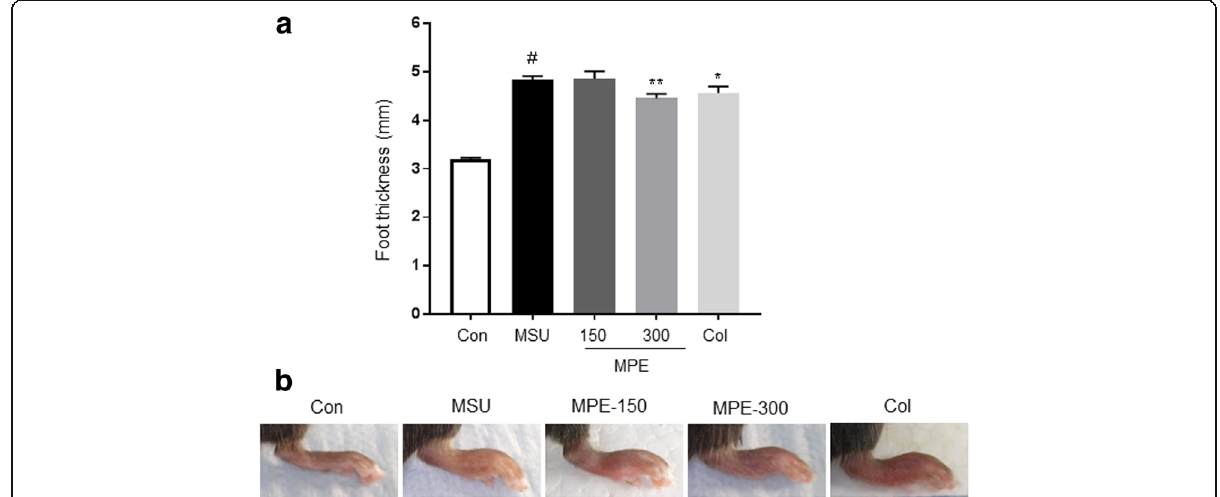
Fig. 1 Effect of MPE on paw edema in mouse with MSU crystal-induced gouty arthritis. Con, control mice; MSU, MSU crystal-induced mice; MPE-150, MSU mice treated with 150 mg/kg of MPE; MPE-300, MSU mice treated with 300 mg/kg of MPE; Col, MSU mice treated with 1 mg/kg of colchicine. a Measurement of the thickness of the each mice paw recorded at the end of the experimental period. b Representative images of the left leg from each group are shown. Data are presented as the mean ± SEM ( n = 5). # p < 0.0001, vs. control group; ** p < 0.01, vs. MSU group, * p < 0.05, vs. MSU